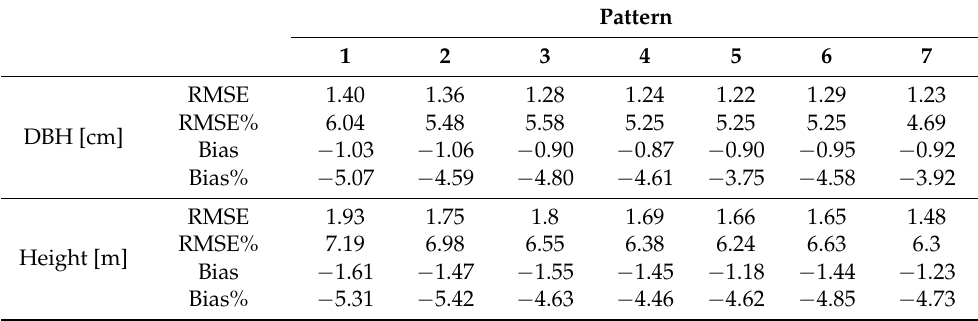
Table 6. Comparison and accuracy assessment of values between two survey methods (DBH, Height).